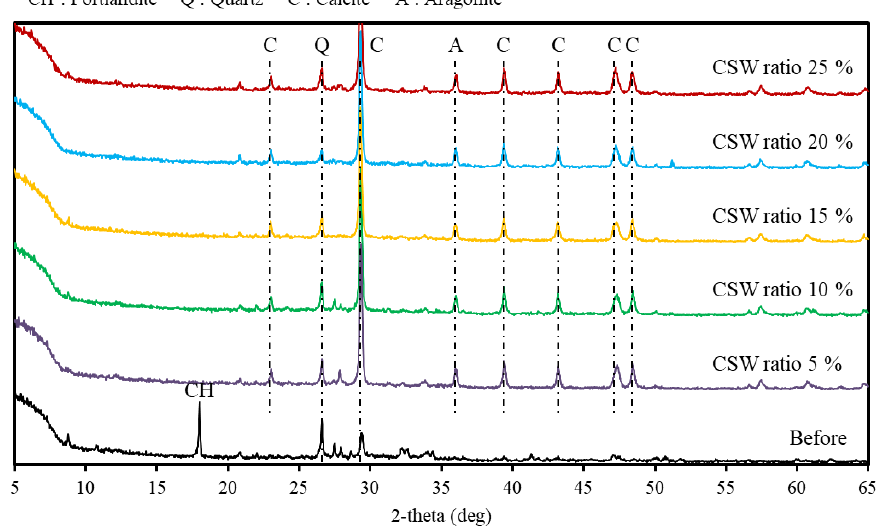
Figure 6. X-ray diffraction results.